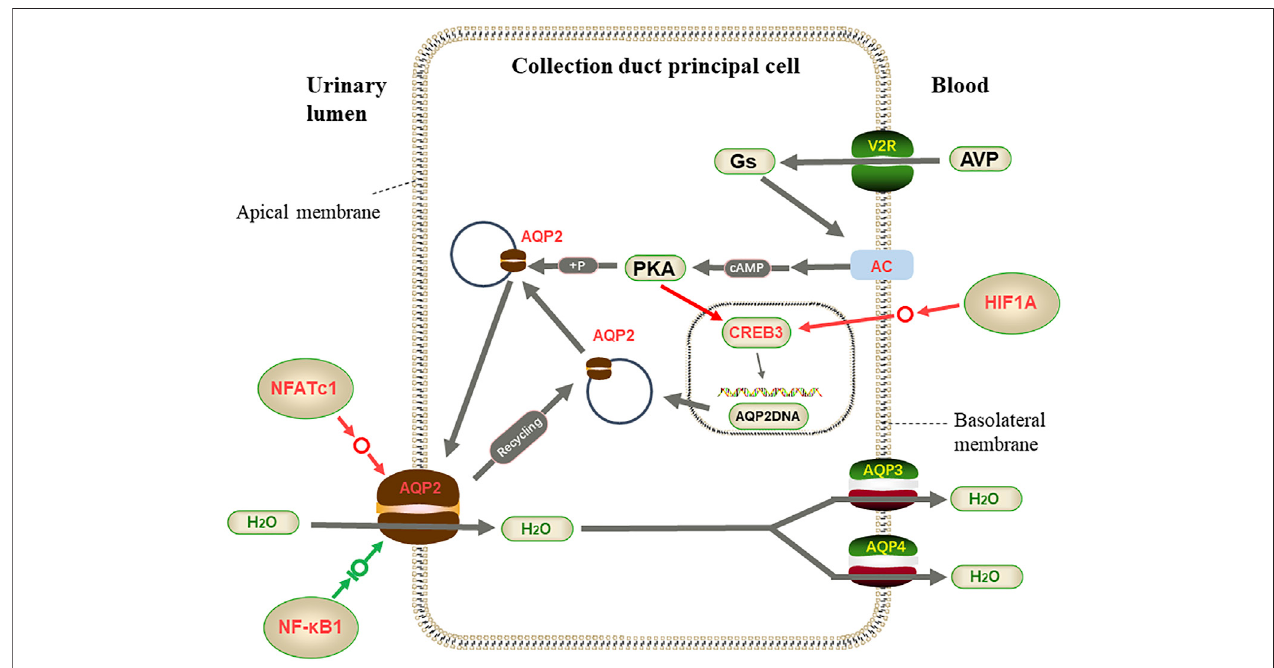
FIGURE10| Partofvasopressin-regulatedwaterreabsorption.Whenthecollectingductisoverhydratedorthebodyisdehydrated,AVPreleasedfromthepituitary bindstovargininevasopressinreceptor2(AVPR2)toactivateadenylatecyclase(AC)andcatalyzecyclicadenosinemonophosphate( cAMP